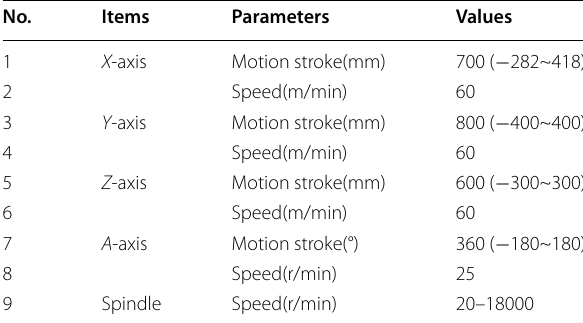
Table 2 The basic parameters of machine tool